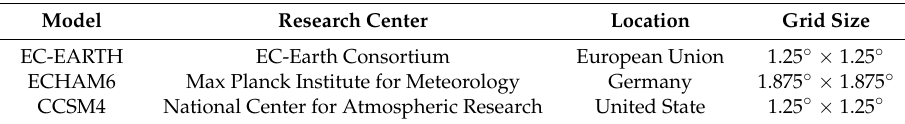
Table 2. Features of the three adopted GCMs (Global Circulation